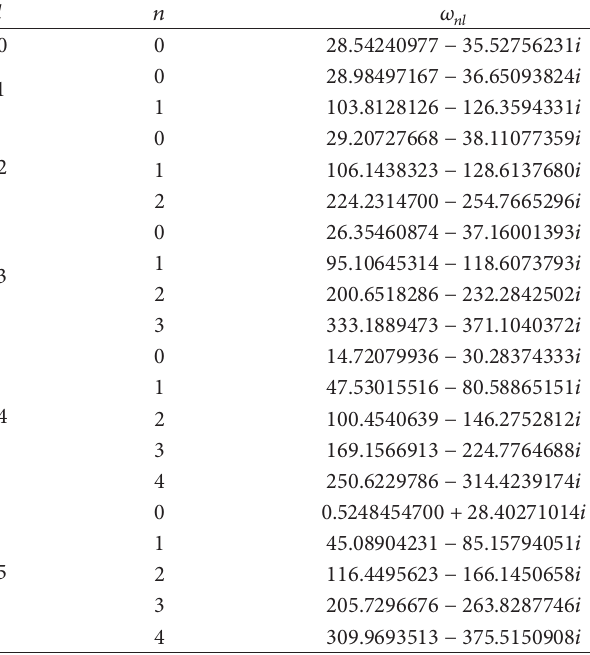
Table 2: Quasinormal modes of scalar perturbations for 𝛼 0 = 2 with 𝑀 = 1 and 𝜇 = 0